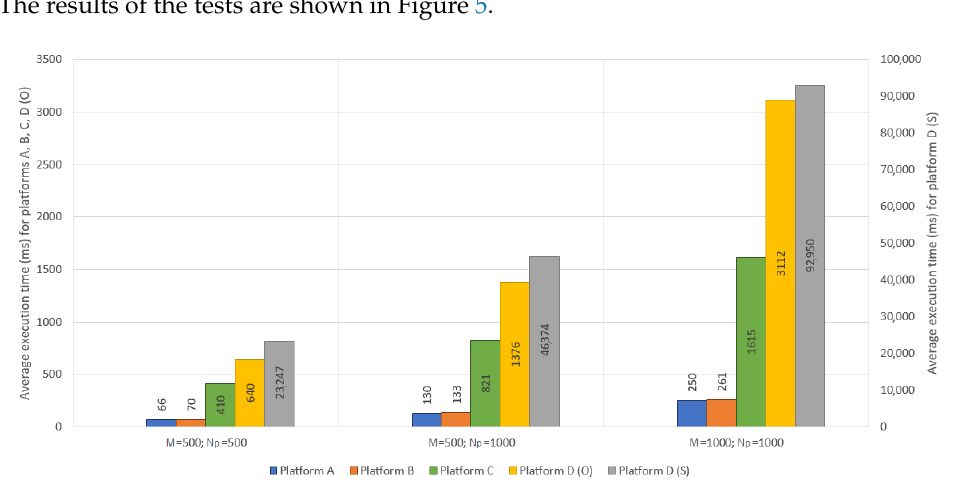
Figure 5. The performance comparison between platform. The results were obtained for M = 1000 and N p = 1000; M = 500 and N p = 1000; M = 500 and N p = 500; and single thread only.